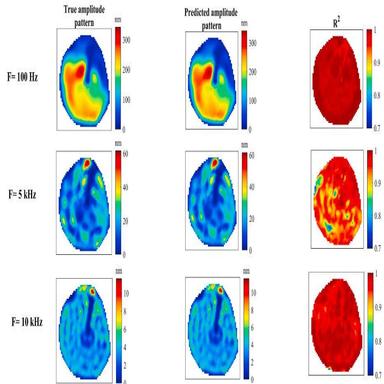
ML model prediction results of the TM amplitude vibration pattern. The results are presented at three frequencies: 100 Hz (low), 5 kHz (middle), and 10 kHz (high). The left and middle columns show the true and predicted vibration amplitude patterns for one of the random test sets, respectively. At all these three frequencies, the predicted amplitude pattern is very close to the true pattern. The rightmost column represents the values of R2 at these frequencies. The values of R2 presented in this column are